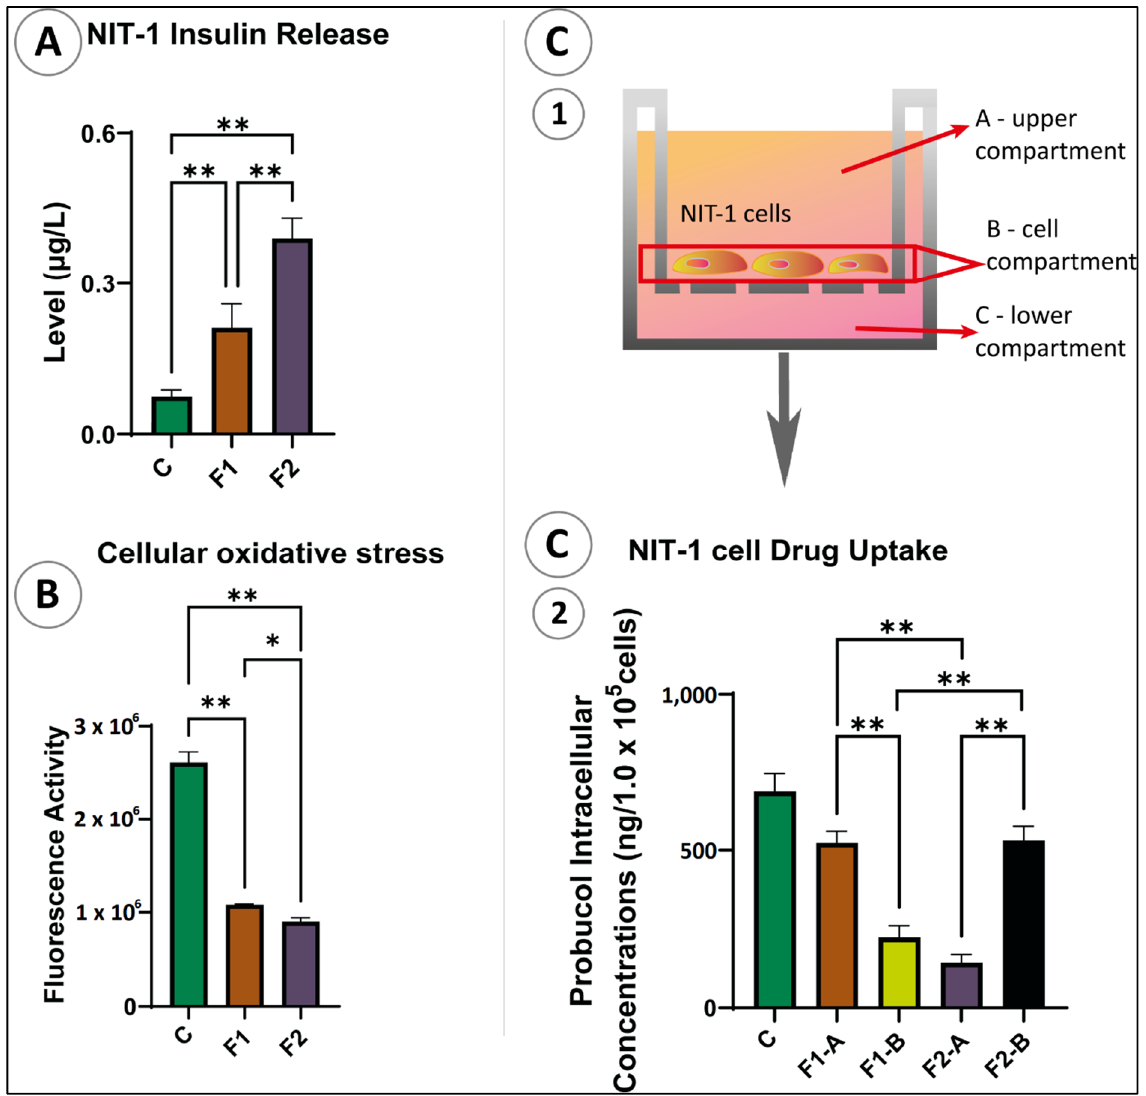
Figure 5. ( A ) Insulin release, ( B ) level of oxidative stress, ( C1 ) transwell, ( C2 ) PB cellular uptake of NIT-1 cell after exposure to the microcapsules; F1 = PB-SA microcapsules, F2 = PB-LCA-SA microcapsules. N = 3, mean ± SD. p < 0.05*, p < 0.01**.